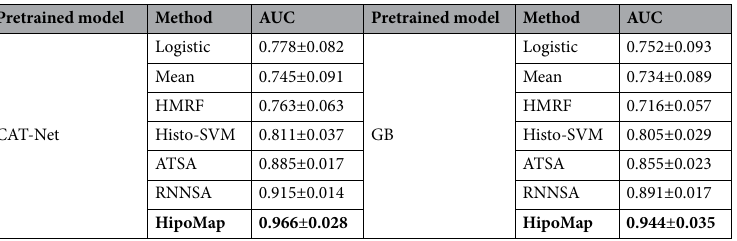
Table 3. Comparison of AUC between the benchmark methods and our proposed HipoMap. The highest AUCs are highlighted in bold.